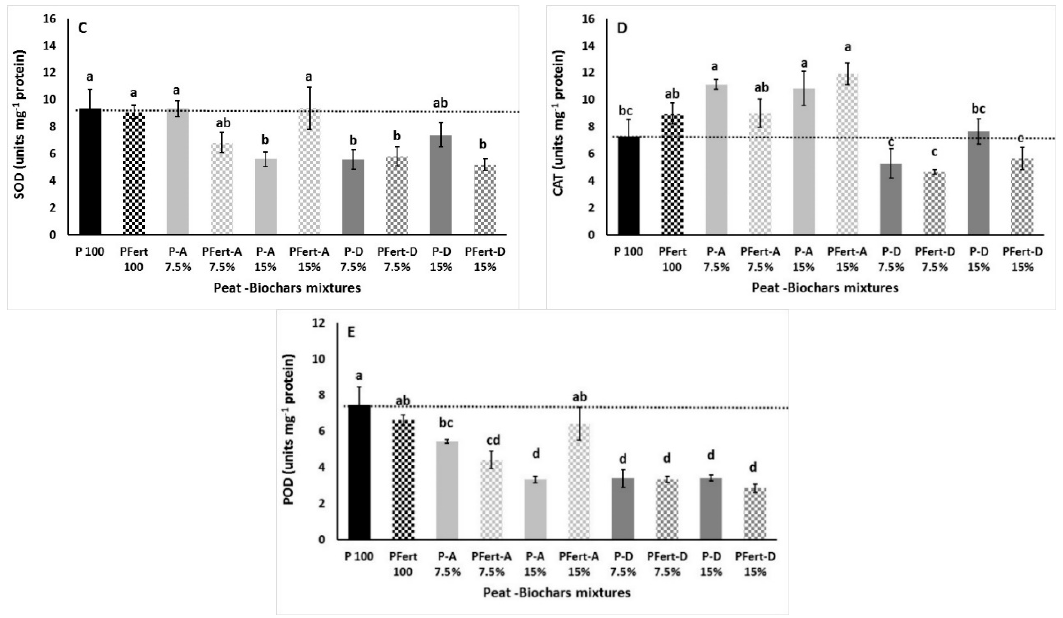
Figure 3. Effects of peat (P 100) with different biochar types (A, D) and ratio (7.5%, 15%) and mineral doses (with standard or with additional Fertilizers-Fert.) on cabbage lipid peroxidation, hydrogen peroxide and antioxidant enzymes activity. ( A ) H 2 O 2 , ( B ) Lipid peroxidation (MDA), ( C ) SOD, ( D ) CAT, and ( E ) POD. Significant differences ( p < 0.05) among treatments are indicated by different letters. Error bars show SE ( n = 4). Dotted line present the levels of control treatment (100% peat).